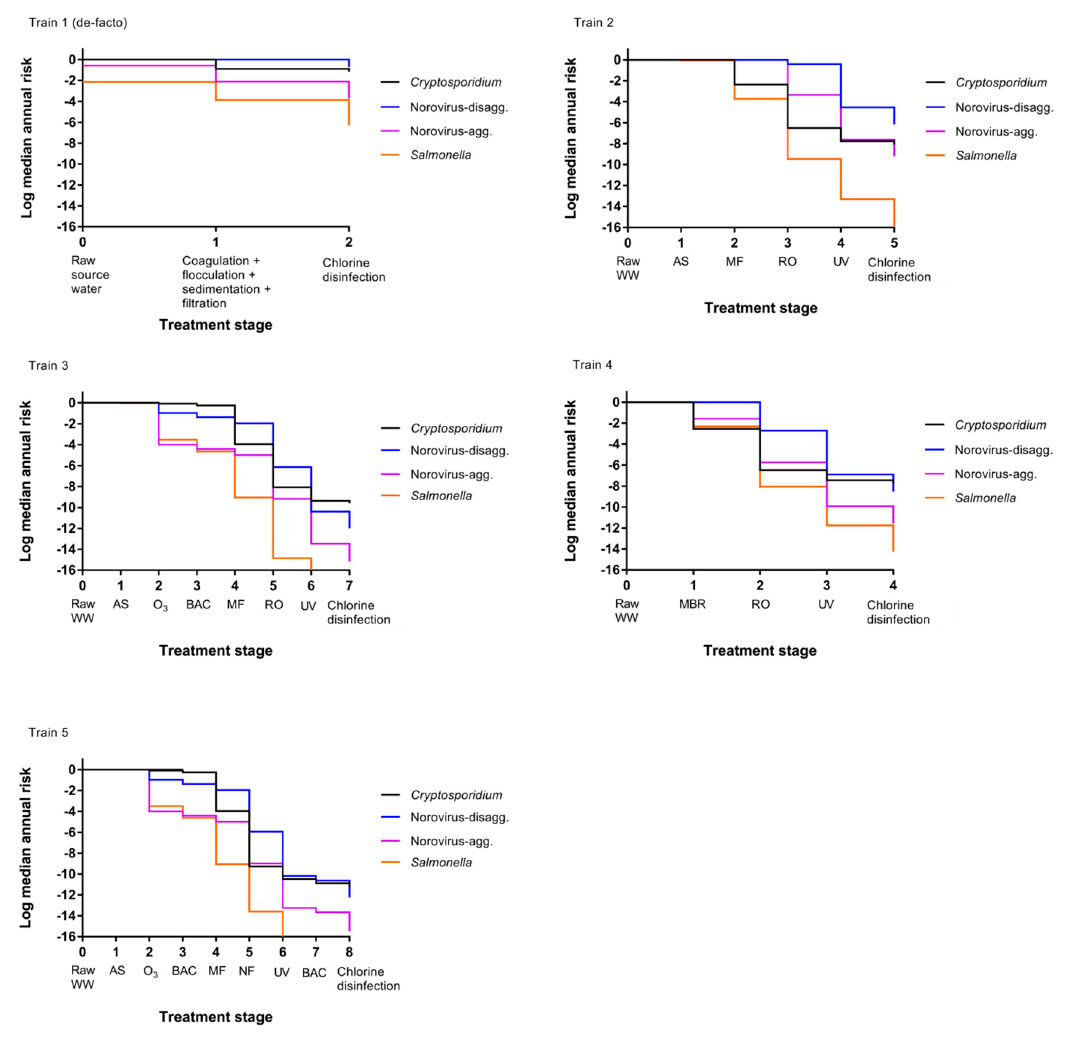
Figure 3. Change in median annual risk at each treatment stage. Train 1 (de-facto) assumes source water comprised of 50% secondary treated wastewater effluent. See Table 1 for a description of direct potable reuse (DPR) Trains 2 through 5.